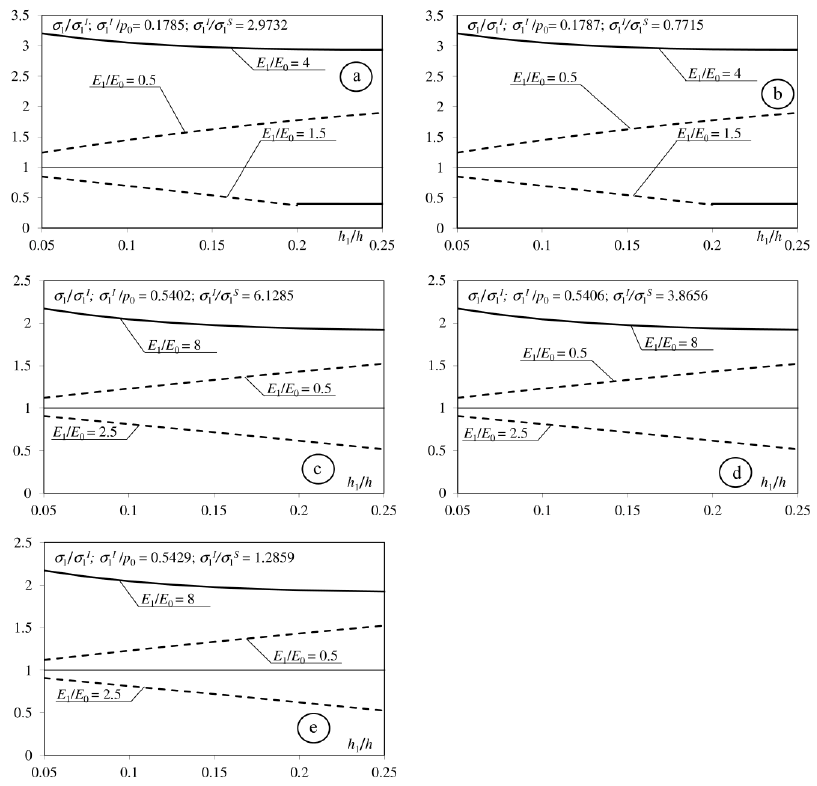
Figure 7. Dependence of the maximum tensile stress on the interface between components of the considered half-space to the h 1 / h parameters. Dashed line: top layer — interlayer interface; solid line: base — interlayer interface. h = 0.8; E 2 / E 0 = 2 ( a ): f = 0; ( b ): f = 0.1); E 2 / E 0 = 4 ( c ): f = 0; ( d ): f = 0.1; ( e ): f = 0.25.